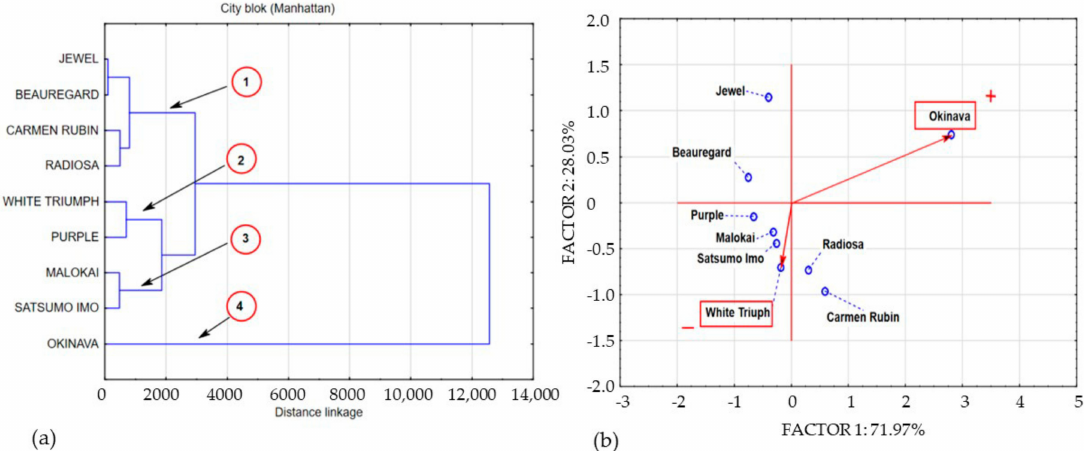
Figure 2. Dendrogram and bio-plot (PCA) of average concentrations of polyphenols in sweet potato leaves collected in BBCH phase 14. ( a ) 1,2,3,4 clusters. ( b ) + variety with the highest concentration polyphenolics compounds, − variety with the lowest concentration polyphenolics compounds.